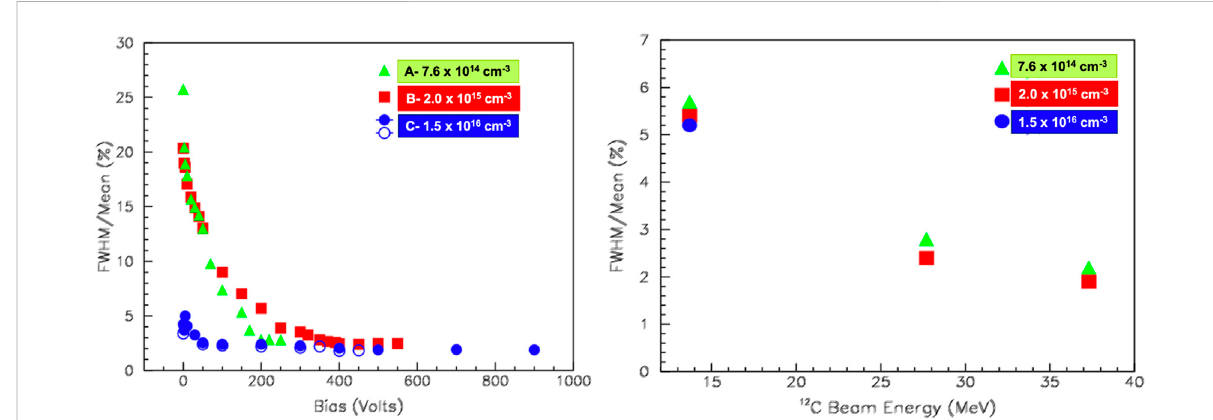
FIGURE 5 Left: Relative energy resolution measured using 12 C at 27.7 MeV as a function of the bias for three SiC with different epitaxial doping concentrations. Right: Energy resolution as a function of 12 C incident energies, measured in the pulse-height saturation regime. Data are from